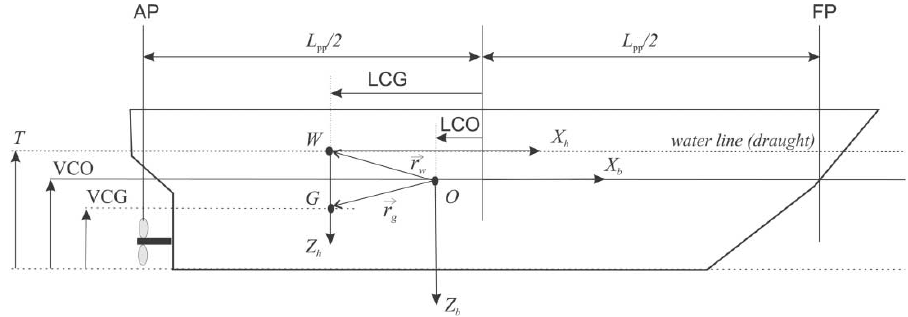
Figure 1. Definitions of coordinate origins: W (water line), G (centre of gravity), and O (equations of motion). The h -frame is located in W and the b -frame is located in O . The variables LCG , VCG , and T are outputs from VERES while LCO and VCO are user inputs.